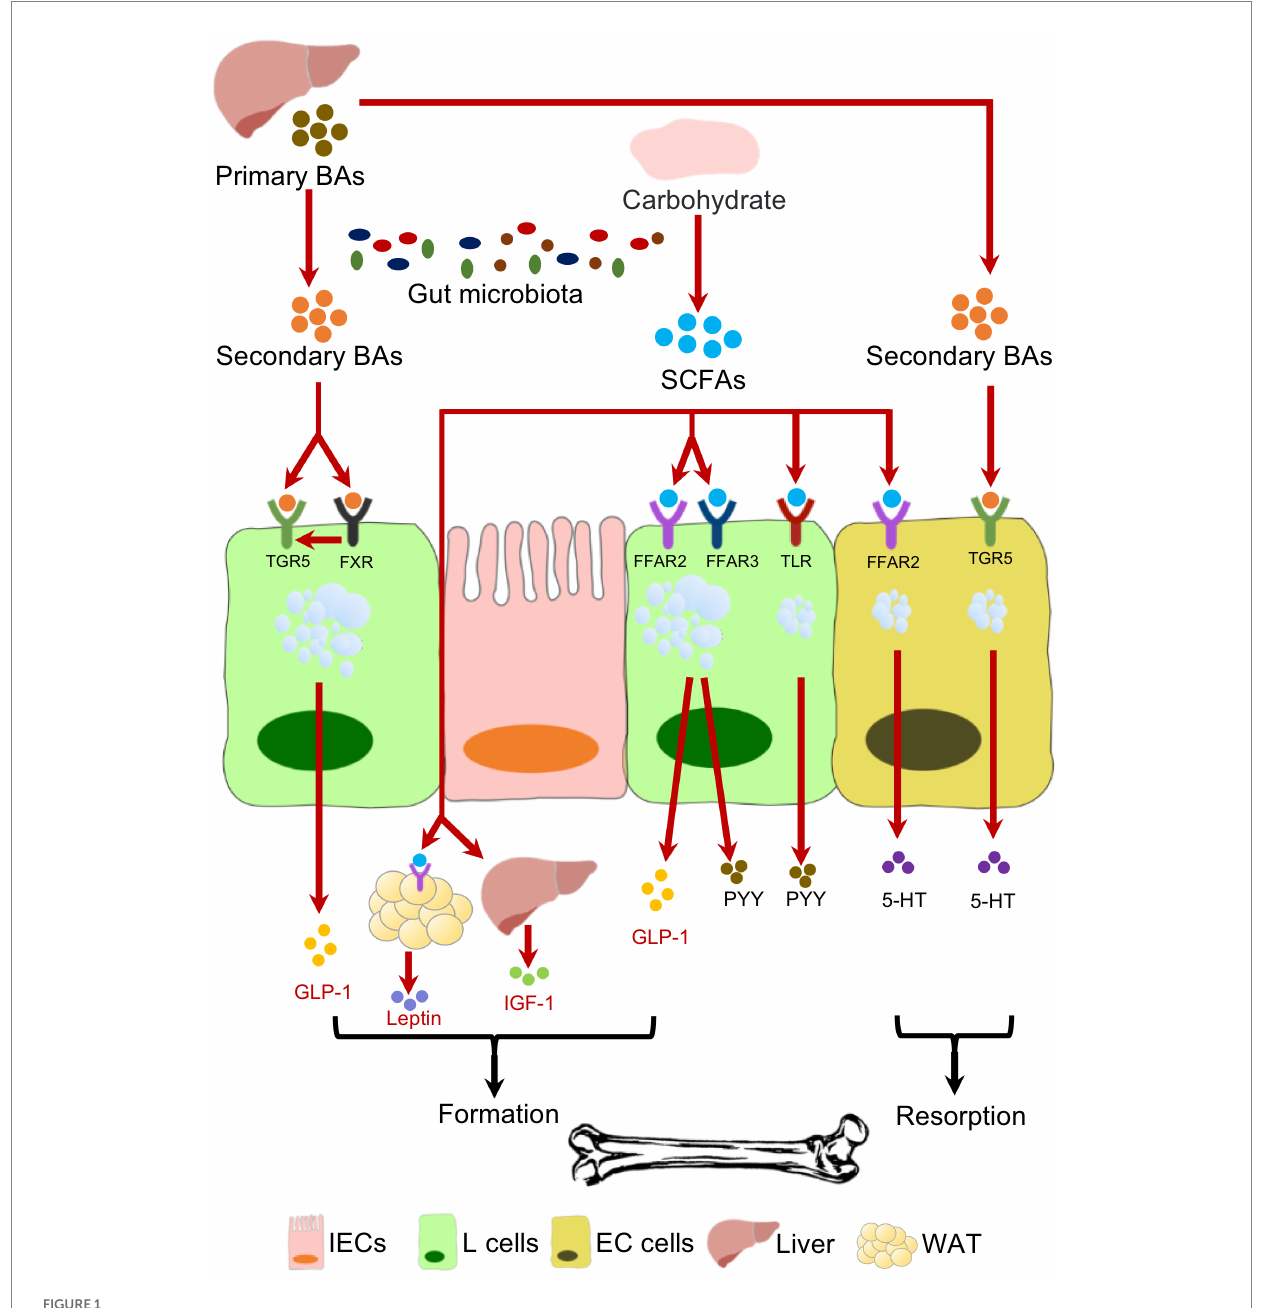
FIGURE 1 The effects of gut microbiota on endocrine-osseous axis mediated by SCFAs and